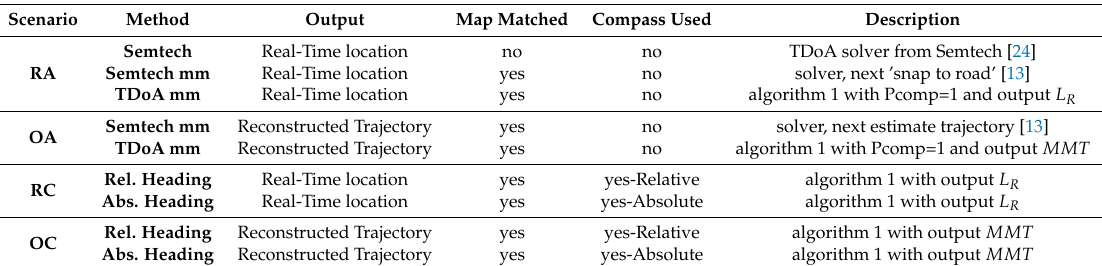
Table 2. Overview of the different methods used to obtain the real-time estimated locations and/or reconstructed trajectory.